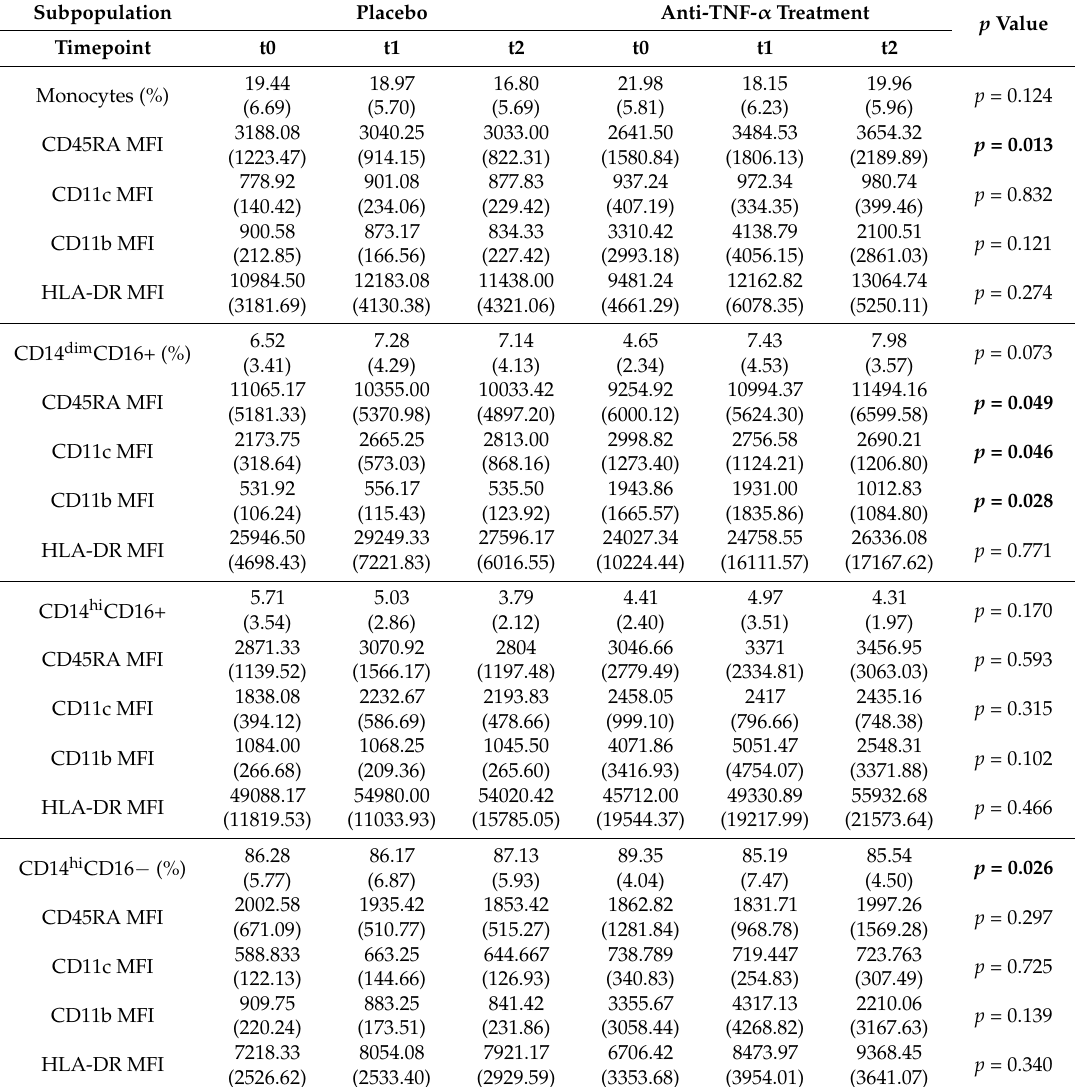
Table 2. Subpopulations of monocytes and their activation markers in different time t0, t1 and t2 in placebo and anti-TNF- α treatment.